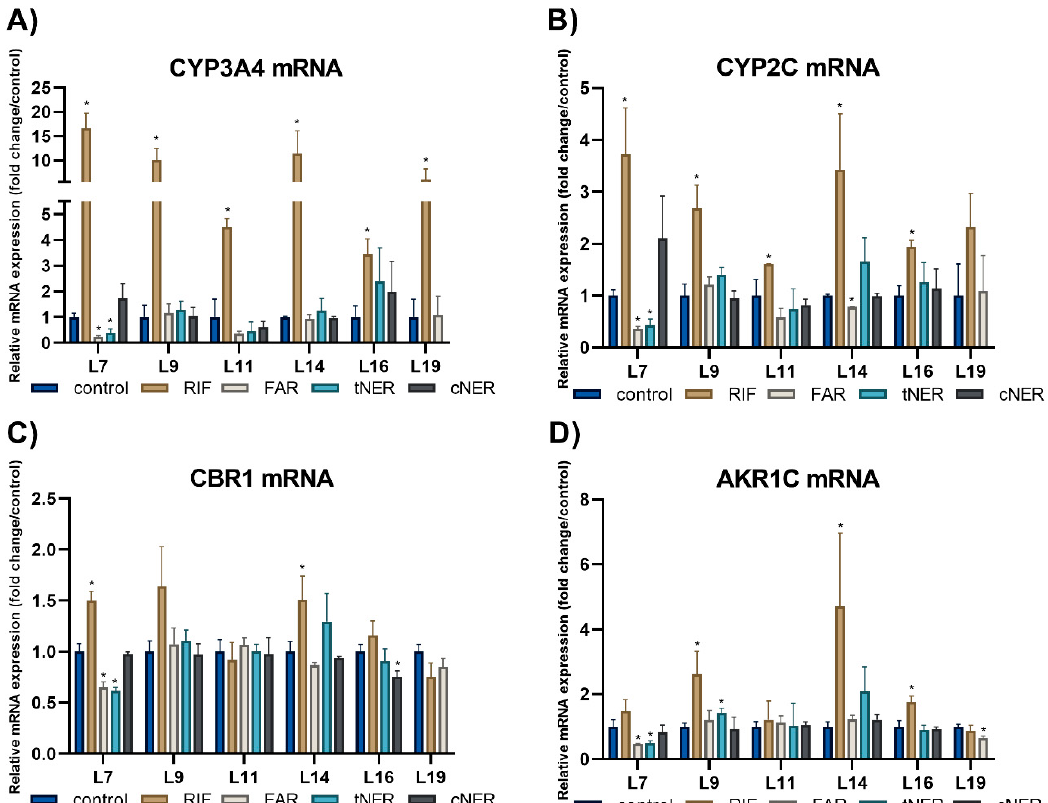
Figure 4. Inter-individual differences in the effect of linear sesquiterpenes (10 µM) and RIF (10 µM) on the normalized mRNA expression of CYP3A4 ( A ), CYP2C ( B ), CBR1 ( C ) and AKR1C ( D ) in human PCLS from five patients after 24 h ( n = 3). The normalized expression level was calculated using the 2 −ΔΔ Ct method with the geometric mean of GAPDH and SDHA as a reference gene. Results are presented as the mean ± SD ( n = 3). Statistical analyses were performed using one-way ANOVA with Dunnett’s test: p < 0.05 (*).